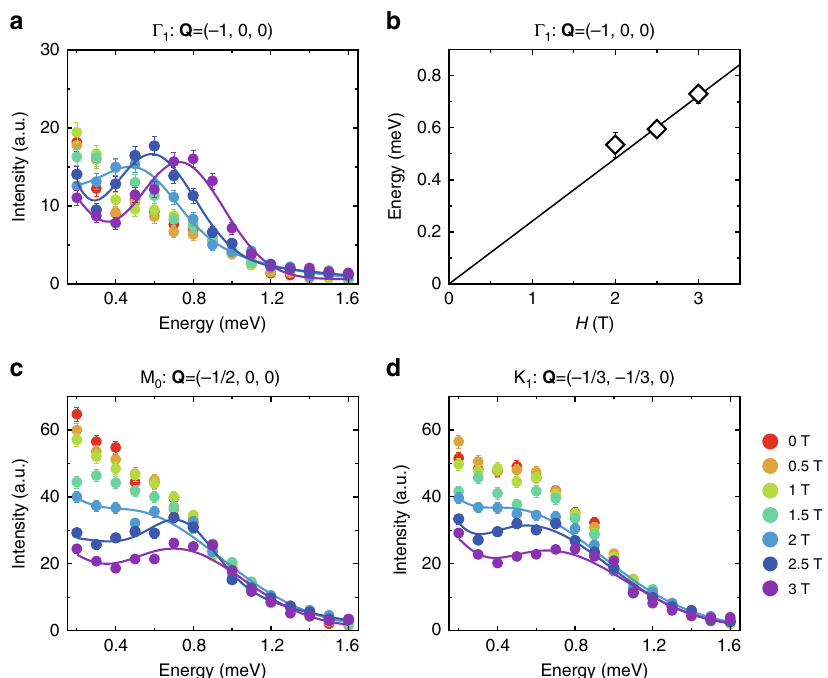
Fig. 4 Field dependence of constant- Q cuts at high-symmetry points at 70 mK. a Constant- Q scans at Γ 1 point under different fi elds at 70 mK. b A linear fi t to the spectral peak positions presented in a gives the Landé g -factor of 4.16(8). c , d Constant- Q scans at M 0 and K 1 points. The solid lines in a , c , and d are guides to the eye. The high intensity at ~0.2 meV is due to background contamination from incoherent elastic scattering at E = 0 meV. The data are collected in the single-detector